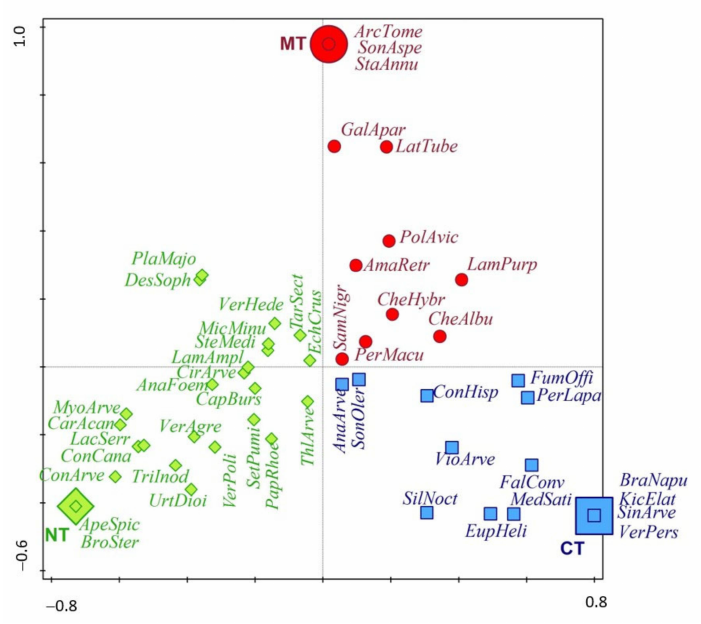
Figure 2. Relationship between identified weed taxa and tillage–result of CCA analysis (total ex-